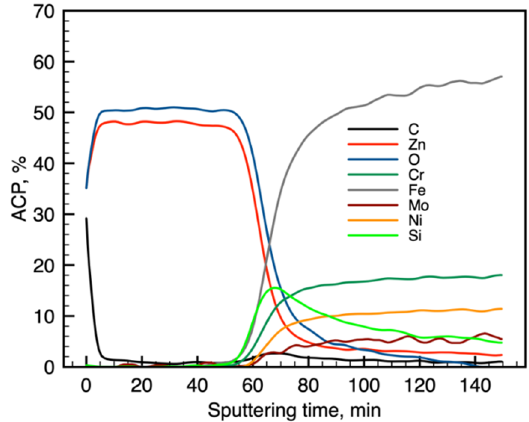
Figure 3. Sandblasted 1500_300: calculated atomic concentration in the depth profile.